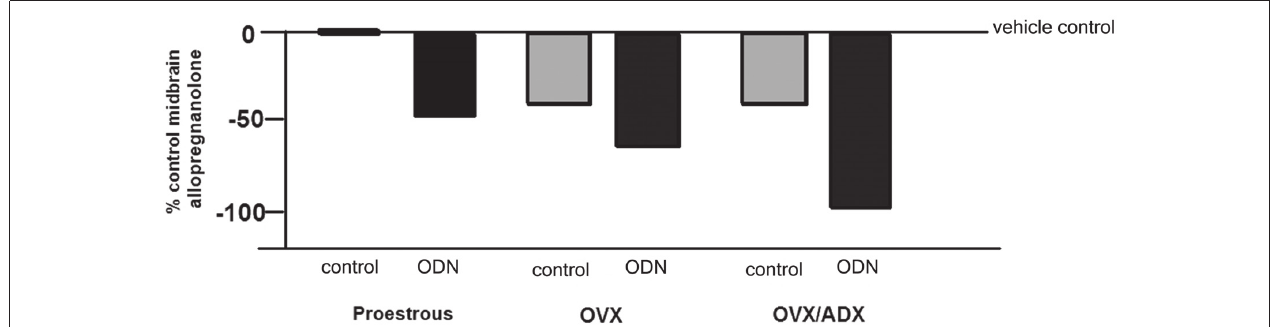
FIGURE 2 | Depicts the midbrain allopregnanolone levels of paced mated proestrous, ovariectomized (OVX) and estradiol-primed, or OVX and adrenalectomized (OVX/ADX) estradiol-primed rats infused with saline vehicle or pregnane xenobiotic receptor (PXR) antisense